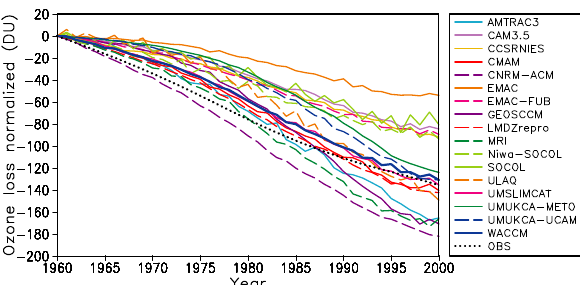
Figure 4. Antarctic total ozone column depletion (in DU, September–October–November average) between 1960 and 2000 due to ESC in REF-B1 CCM simulations and due to EESC in ob- servations, adjusted to a common baseline (1960 mean of